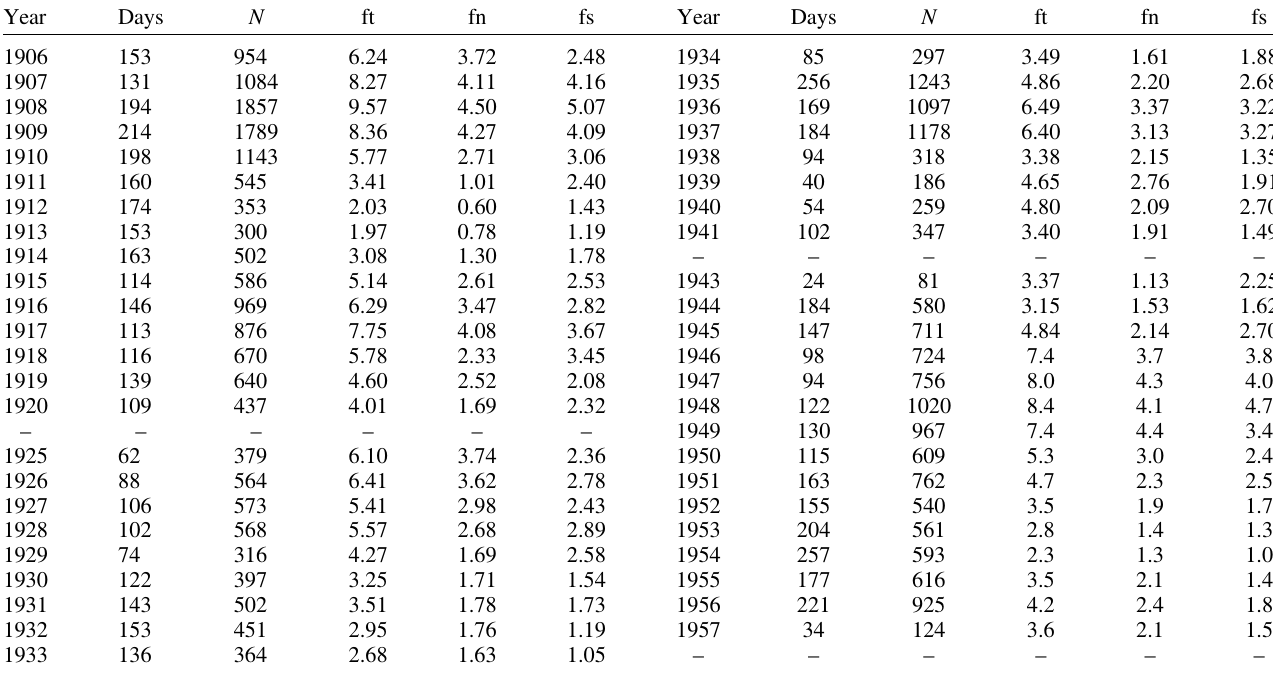
Table 1. Prominence data per year published in the yearbooks and bulletins of the Madrid Astronomical Observatory for the period 1906 – 1957. The columns represent: (i) the year of the observations, (ii) the number of observation days in the corresponding year, (iii) the number of prominences observed in the corresponding year, and frequency of the (iv) total, (v) north, and (vi) south number of prominences (that is, the total, north, and south number of prominences divided by the number of observation days).